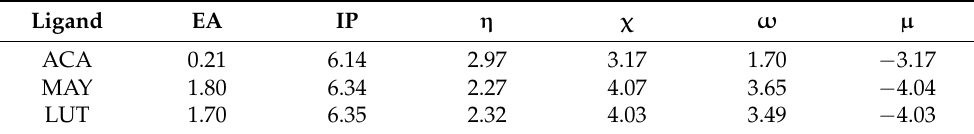
Table 2. Reactivity parameters of docked ligands at M06/6-31G(d) level theory. Electron affinity (EA), ionization potential (IP), chemical hardness ( η ), electronegativity ( χ ), electrophilicity ( ω ), and chemical potential ( µ ). All values are presented in